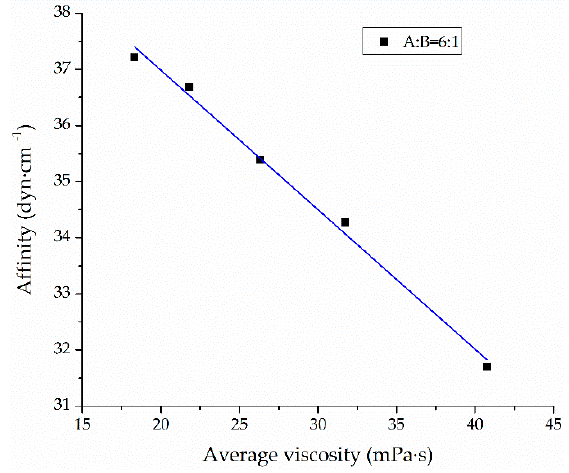
Figure 9. The relationship between average viscosity and affinity of slurry (A:B = 5:1).